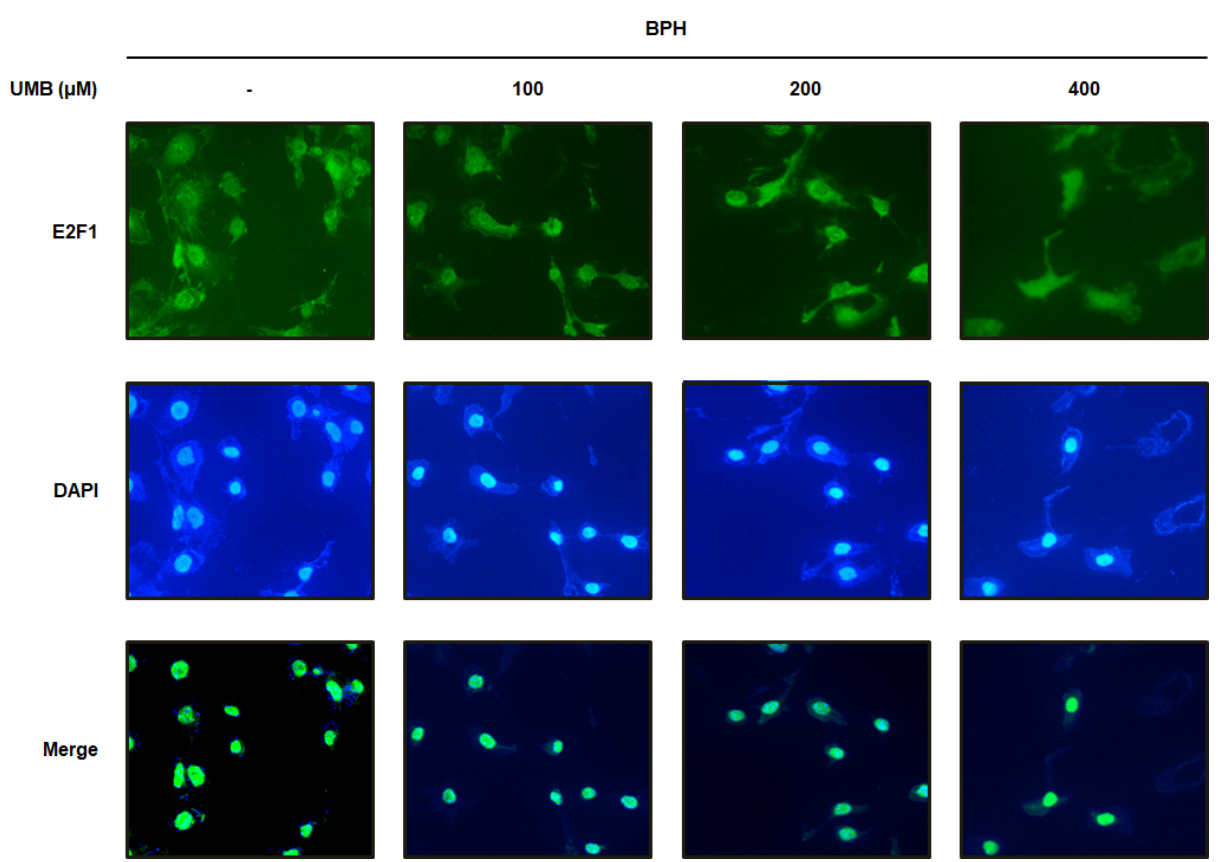
Figure 3. Effect of UMB treatment on E2F1 expression in BPH-1 cells. BPH-1 cells were treated with or without 100, 200, and 400 µ M of UMB. Alexa Fluor 488-incorporated cells (green) were detected by immunofluorescence staining for E2F1. The nuclei were counterstained with DAPI (blue). Merged images represent staining for E2F1 and DAPI. The stained cells were visualized with a fluorescence microscope at 400× magnification.